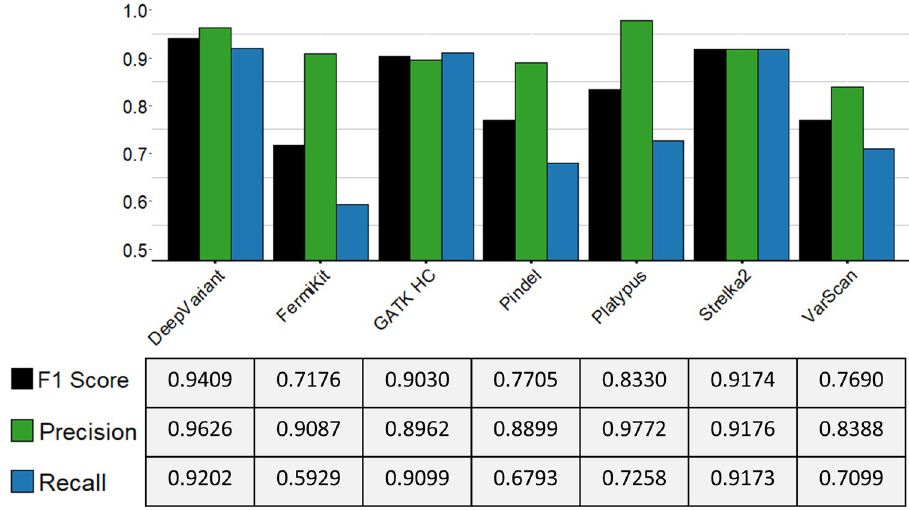
Fig 7. Indel calling evaluation results for variant calling tools with GIAB NA24385 WES data. The evaluation results were calculated using hap.py. The table below shows the values of the precision rates, recall rates, and F1 scores of each